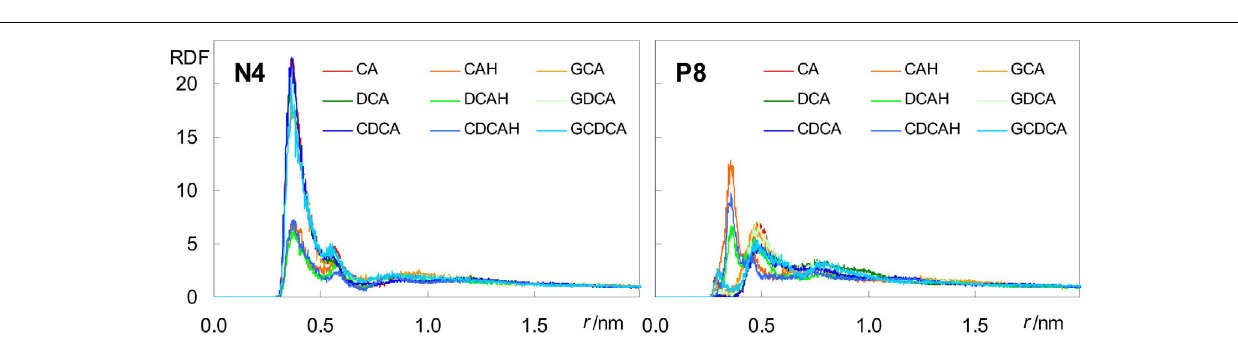
FIGURE 7 | Radial distribution functions (RDFs) of POPC N4 (left) and P8 (right) atoms around BS carboxylate O